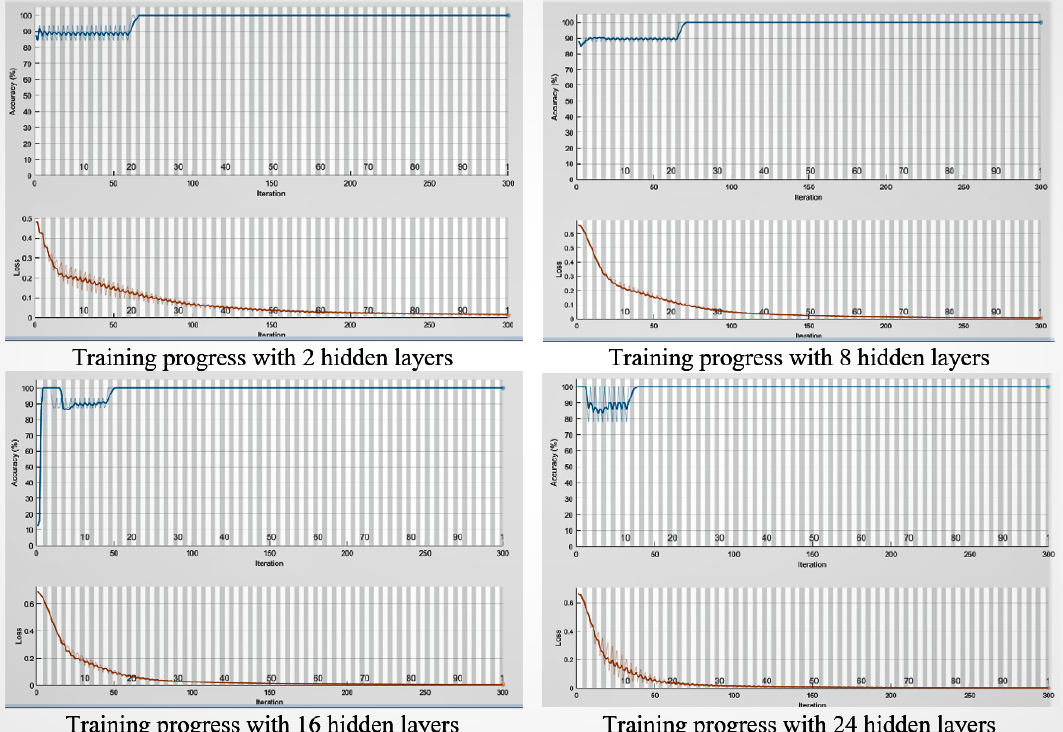
Figure 8. Training progress with various hidden